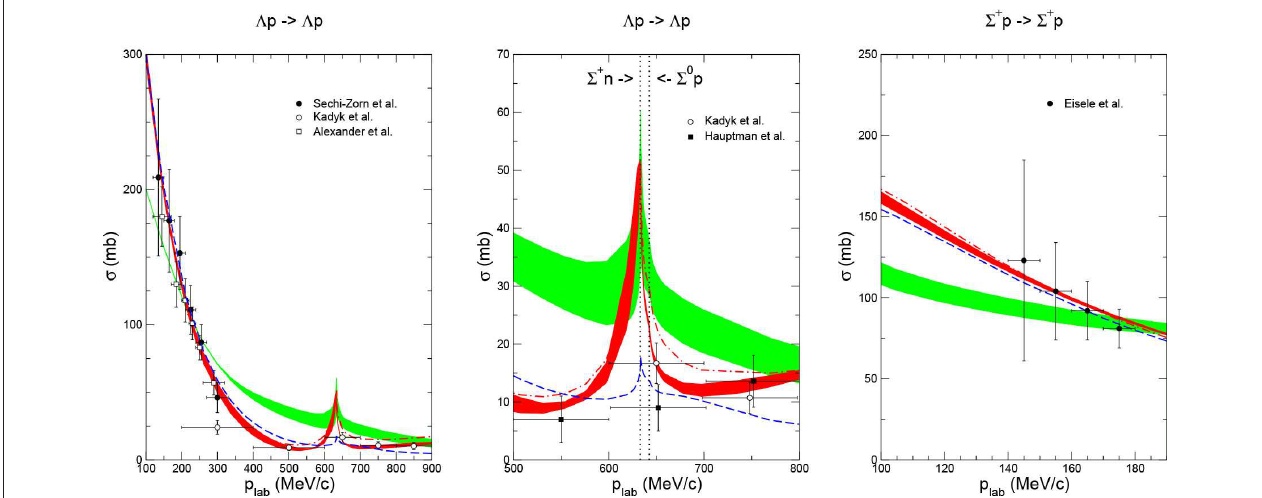
FIGURE 13 | Total cross section σ as a function of p lab . The red (dark) band shows the chiral EFT results to NLO for variations of the cutoff in the range 3 (500 ... 650) MeV [ 33], while the green (light) band are results to LO for 3 = meson-exchange potential [ 21], the dash-dotted curves of the Nijmegen NSC97f potential